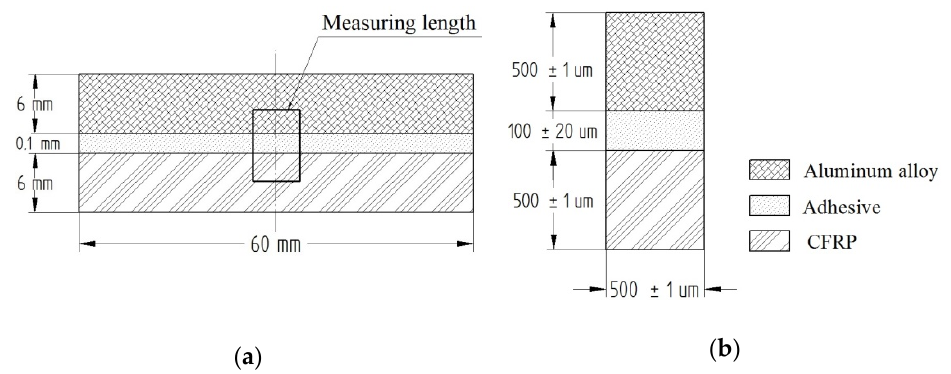
Figure 5. Dimensions of measuring length: ( a ) diagram of sample, ( b ) measuring length.